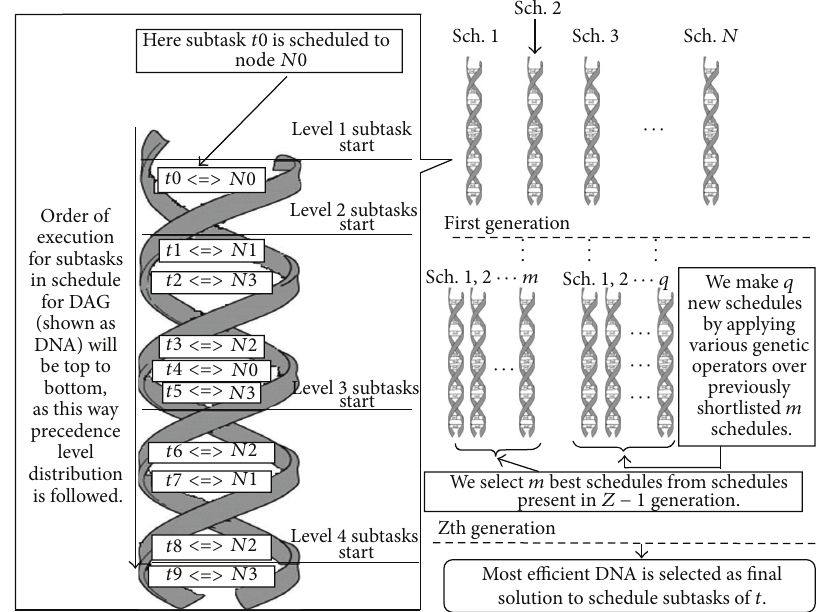
Figure 2: DNA representing scheduling for subtasks of task 𝑡 and use of genetic algorithm to obtain good schedule.